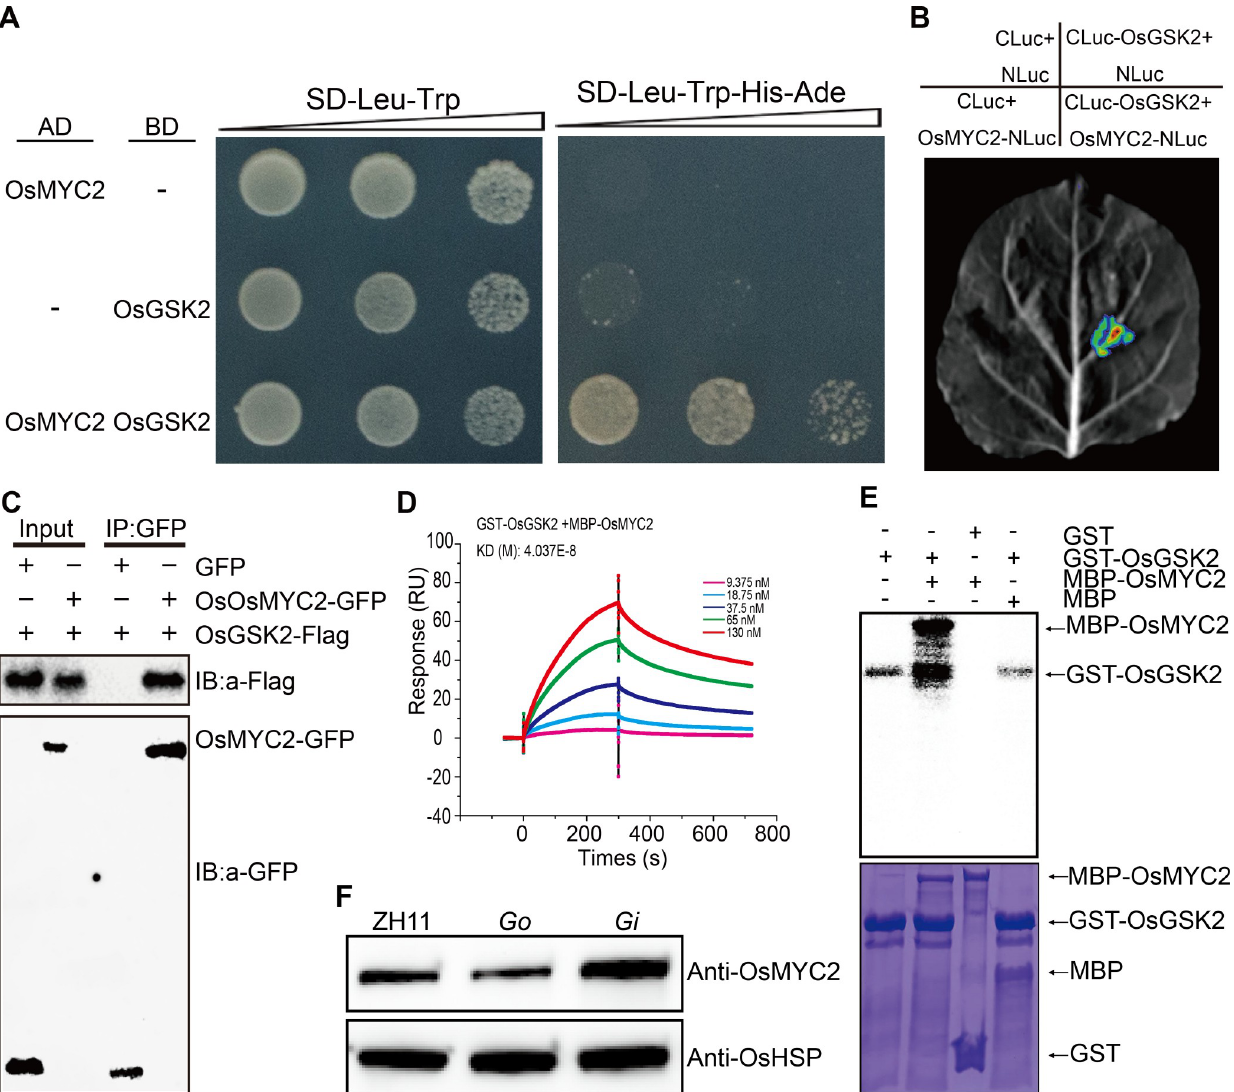
Fig 8. OsGSK2 interacts with and phosphorylates OsMYC2. (A) Interaction between OsGSK2 and OsMYC2 detected in the yeast two-hybrid system. (B) Interaction between OsGSK2 and OsMYC2 detected by Luciferase Complementation Imaging (LCI) assay in Nicotiana benthamiana . (C) Interaction between OsGSK2 and OsMYC2 detected by Co-IP assays in Nicotiana benthamiana . (D) Interaction between OsGSK2 and OsMYC2 detected by physicochemical analysis. The affinity between GST-OsGSK2 and MBP-OsMYC2 was revealed by dissociation rate constant (KD) (dissociation rate / association rate). (E) In vitro phosphorylation assays of GST-OsGSK2 and MBP-OsMYC2. Phosphorylated proteins were detected by autoradiography (top). The proteins used for the phosphorylation assay are shown in the corresponding lower panels with Coomassie blue staining (CBS) (bottom). (F) OsMYC2 protein levels in 14-day seedlings of Go , Gi and the wild-type Zhonghua11 (ZH11) infested with RSV-carrying SBPH. OsHSP indicates loading control.